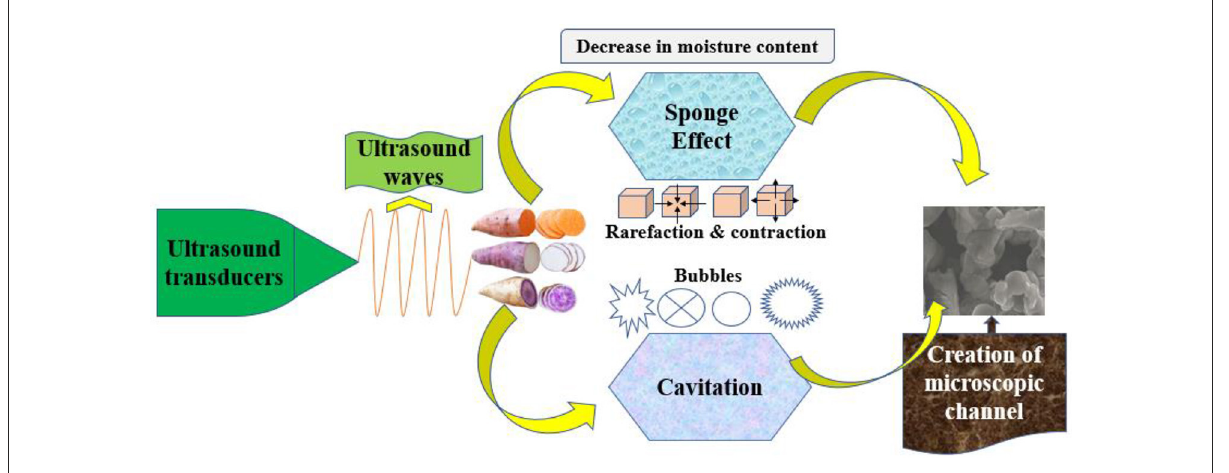
FIGURE8 Ultrasound impact on sweet potatoes